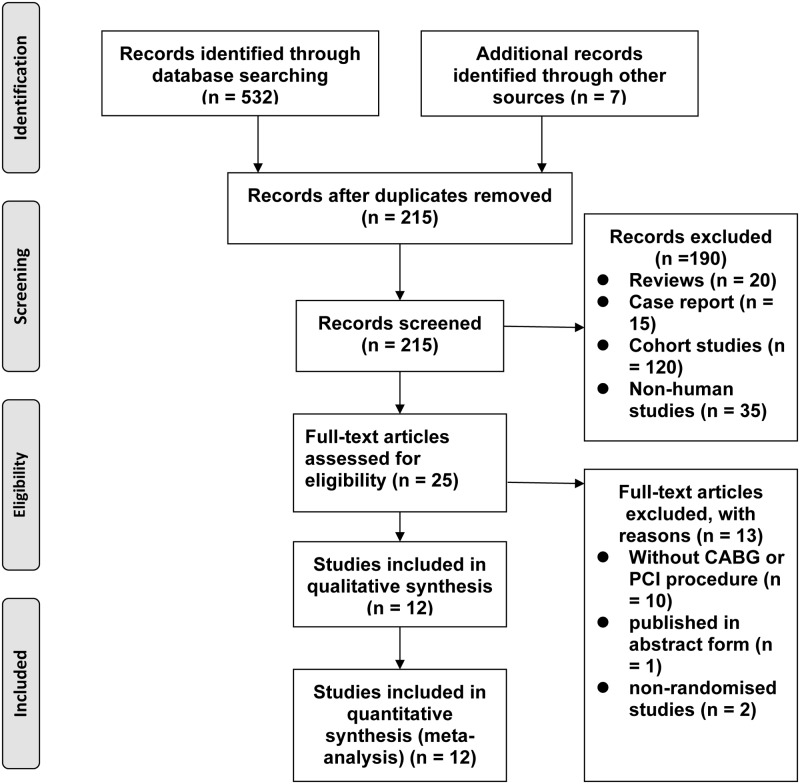
Flow diagram for selection of articles.